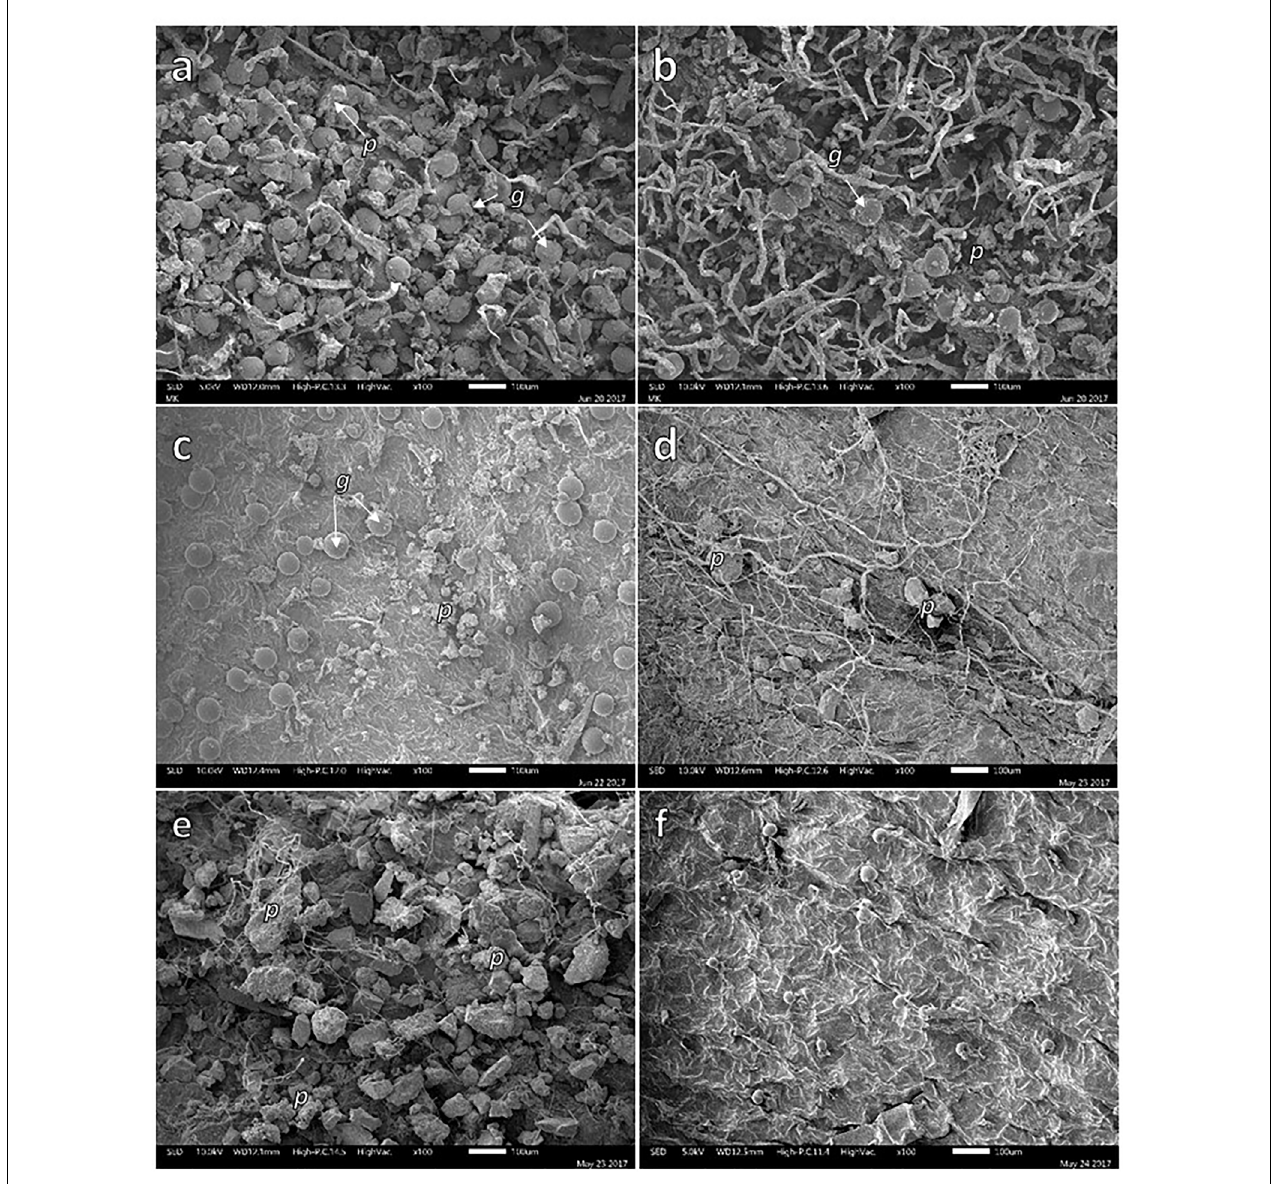
FIGURE 2 | SEM images of solid particles on the adaxial (a,c,d,f) and abaxial face (b,e) of leaves of Brickellia veronicifolia (a–c) and Allionia choisyi (d–f) collected from mine residues (a,b,d,e) or non-polluted control site (c,f) . Particles = p ; glands = g